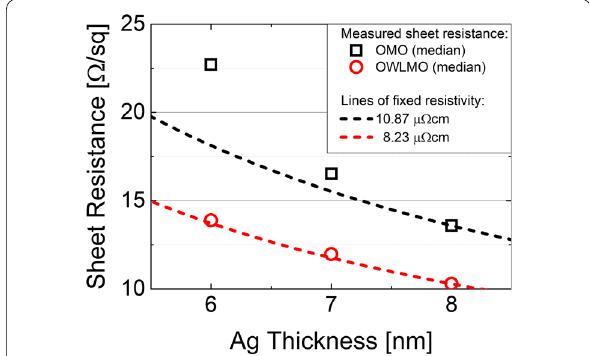
Fig. 2 Comparison of the sheet resistance measured of OMO electrodes of the CIGS solar cells with different thicknesses of the intermediate metal. Samples without (black) and with (red) wetting layers are shown. The dashed lines represent the sheet resistance of OMOs with constant resistivity, as would be expected without a change in morphology of the Ag